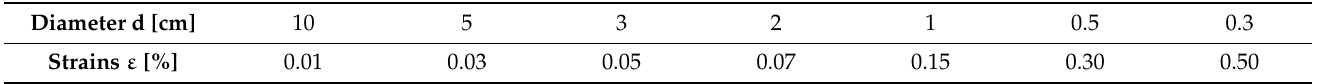
Table 1. Diameters of test specimens and related sample strains used for the bending